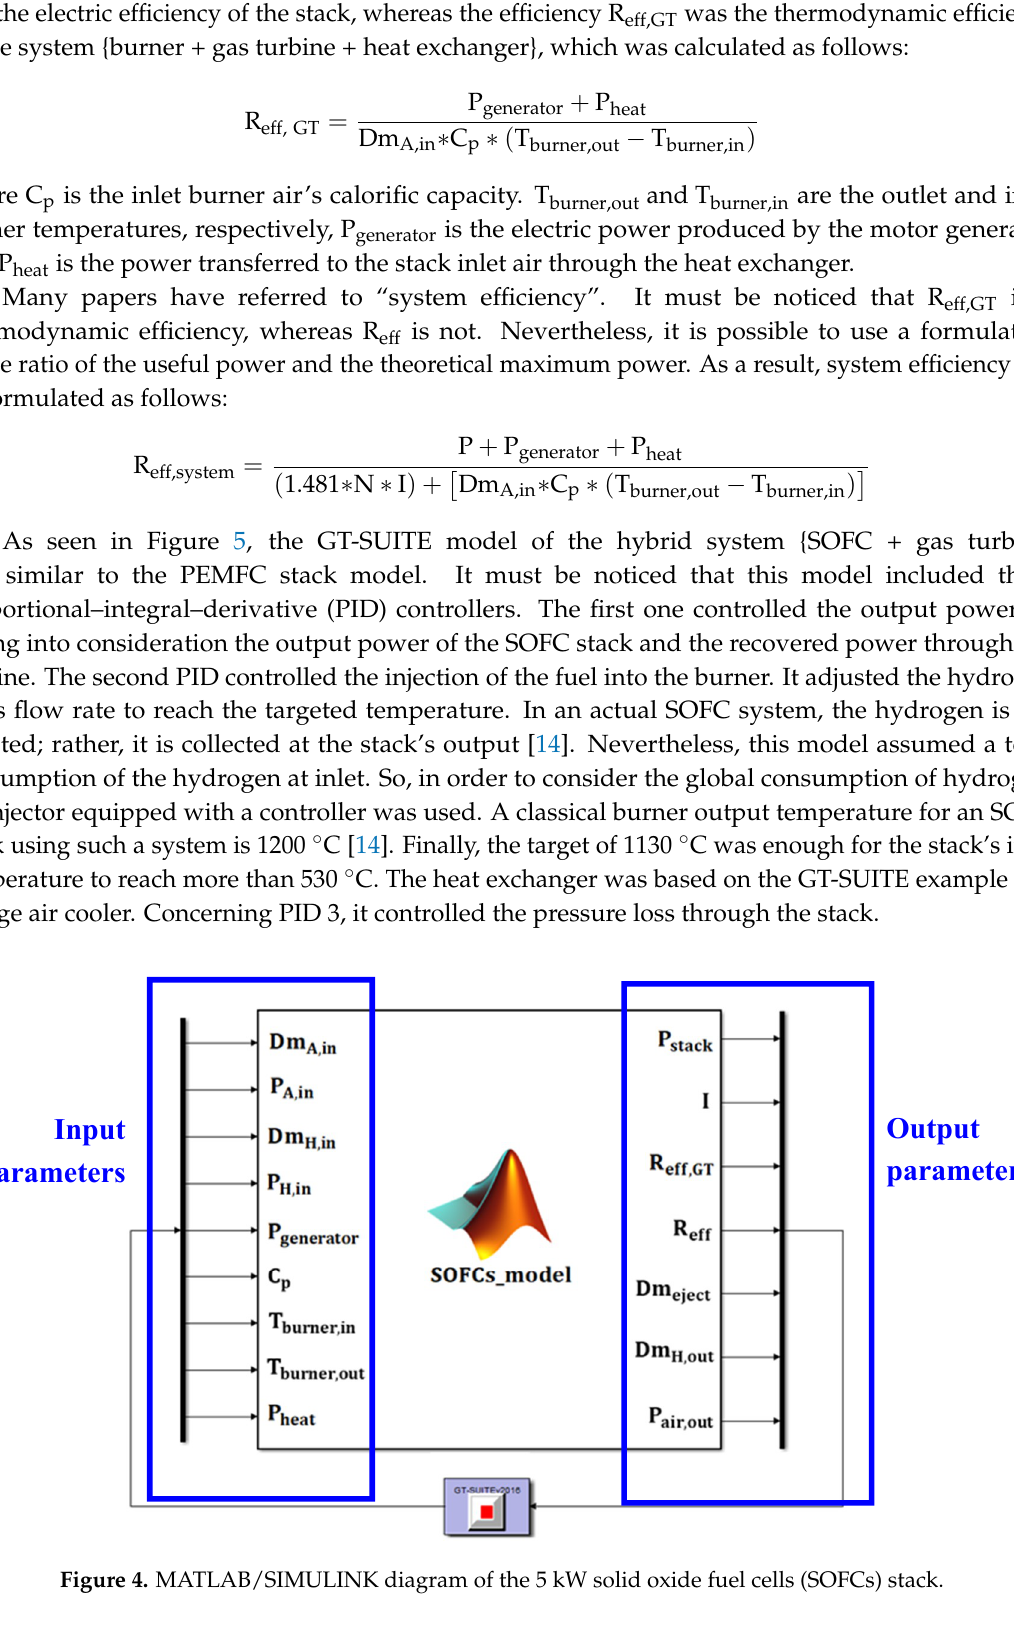
Figure 5. GT-SUITE model of the 5 kW SOFCs stack. 2.3. Compressor and Turbine Scaling Method Air compressors must be adapted to the fuel cell application at hand and the requirements vary significantly compared to equivalent internal combustion engine systems. The compressors that were